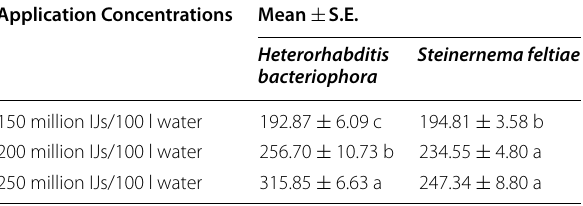
a, b: Values indicated by different letters in the same column are statistically different from each other ( P < 0.05)